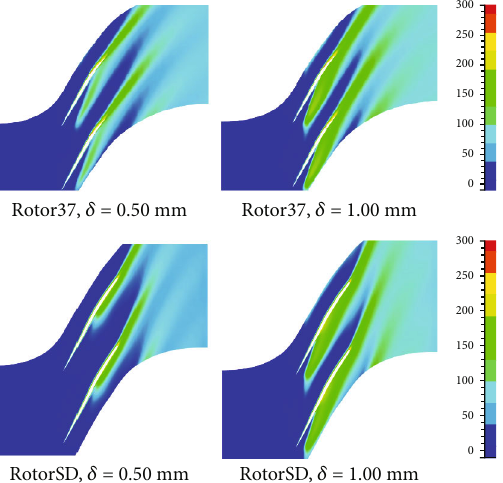
Figure 13: Contours of entropy (J/(kg · K)) in 95%span.